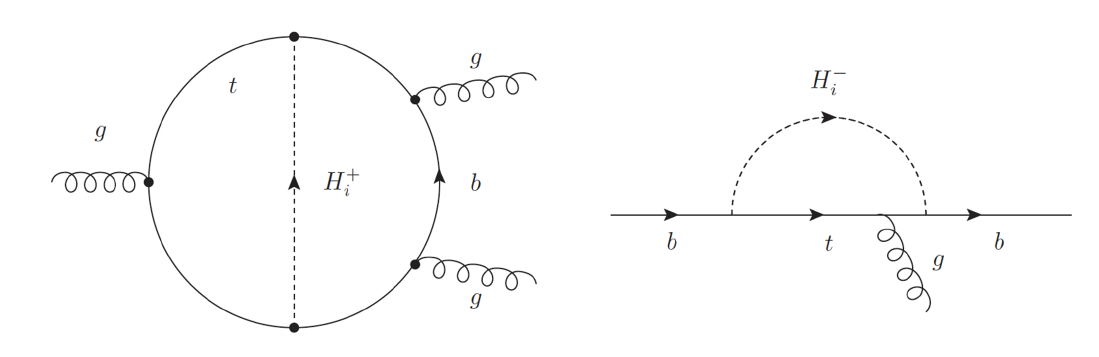
Figure 8 . Left panel: two-loop charged Higgs boson contribution to the Weinberg operator. Right panel: one-loop charged Higgs boson contribution to the bottom quark